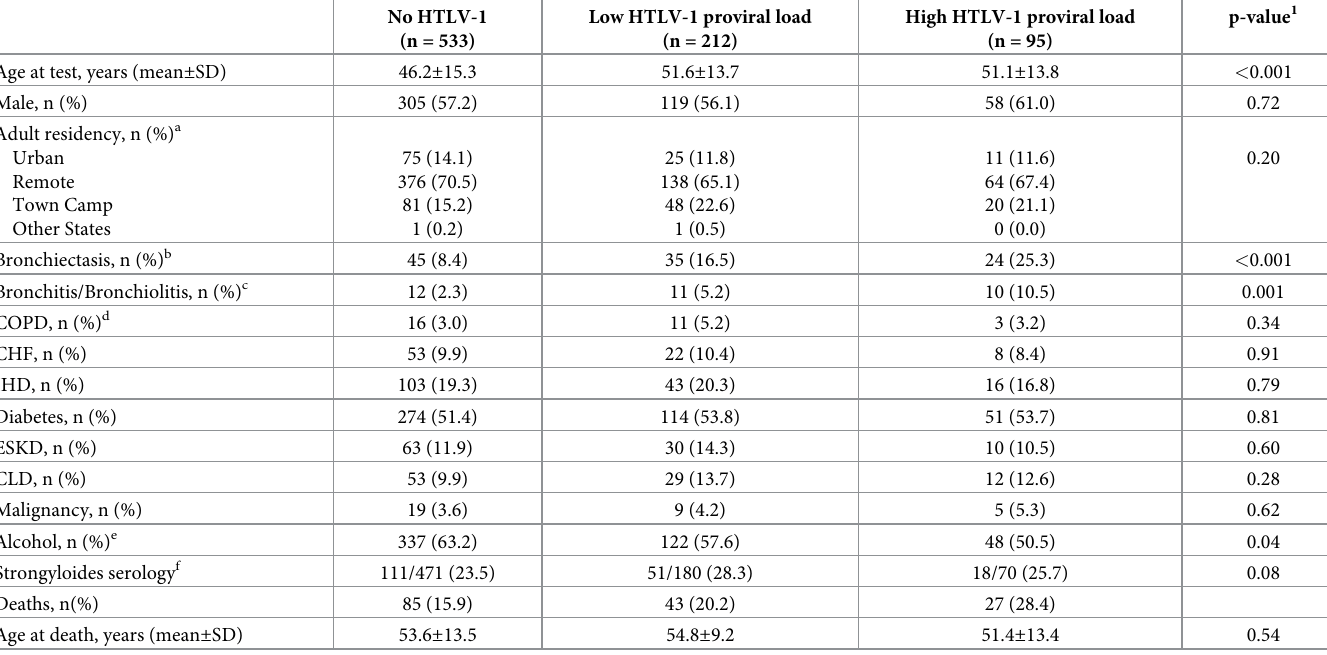
Table 1. Demographics and clinical characteristics of indigenous adults according to HTLV-1 status and HTLV-1 proviral